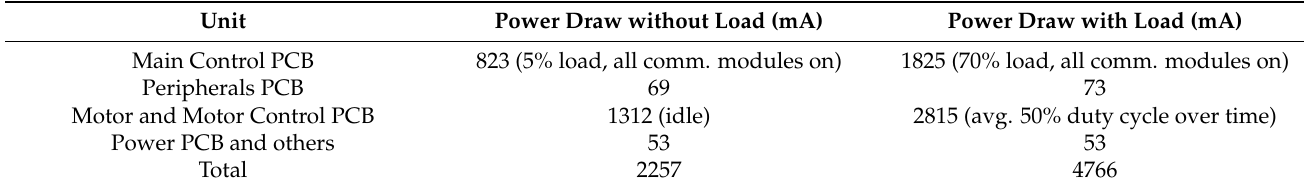
Table 4. Experimental measurements of the power draw of the exoskeleton prototype. Unit Power Draw without Load (mA) Power Draw with Load (mA) Main Control PCB 823 (5% load, all comm. modules on) 1825 (70% load, all comm. modules on) Peripherals PCB 1312 (idle) Power PCB and others 53 Total